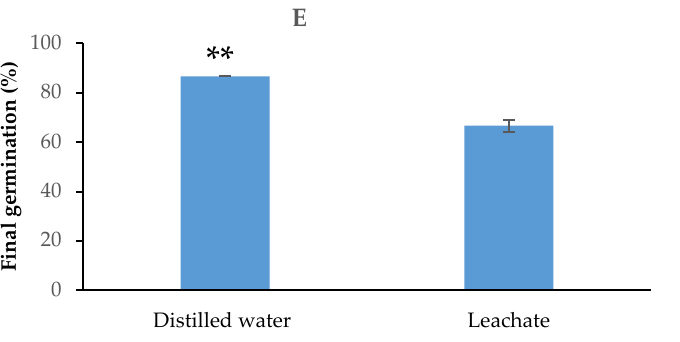
Figure 3. Effect of Hypoxis hemerocallidea leachate on tomato seed germination: mean germination time ( A ), germination index ( B ), coefficient of velocity of germination ( C ), germination rate index ( D ), and final germination percentage ( E ). *, ** = significant at p < 0.10 or p < 0.05, respectively.